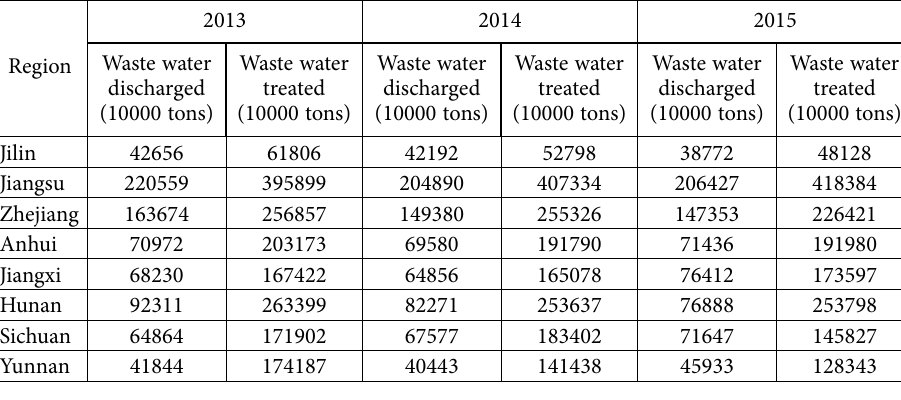
Table 5. Price of industrial water